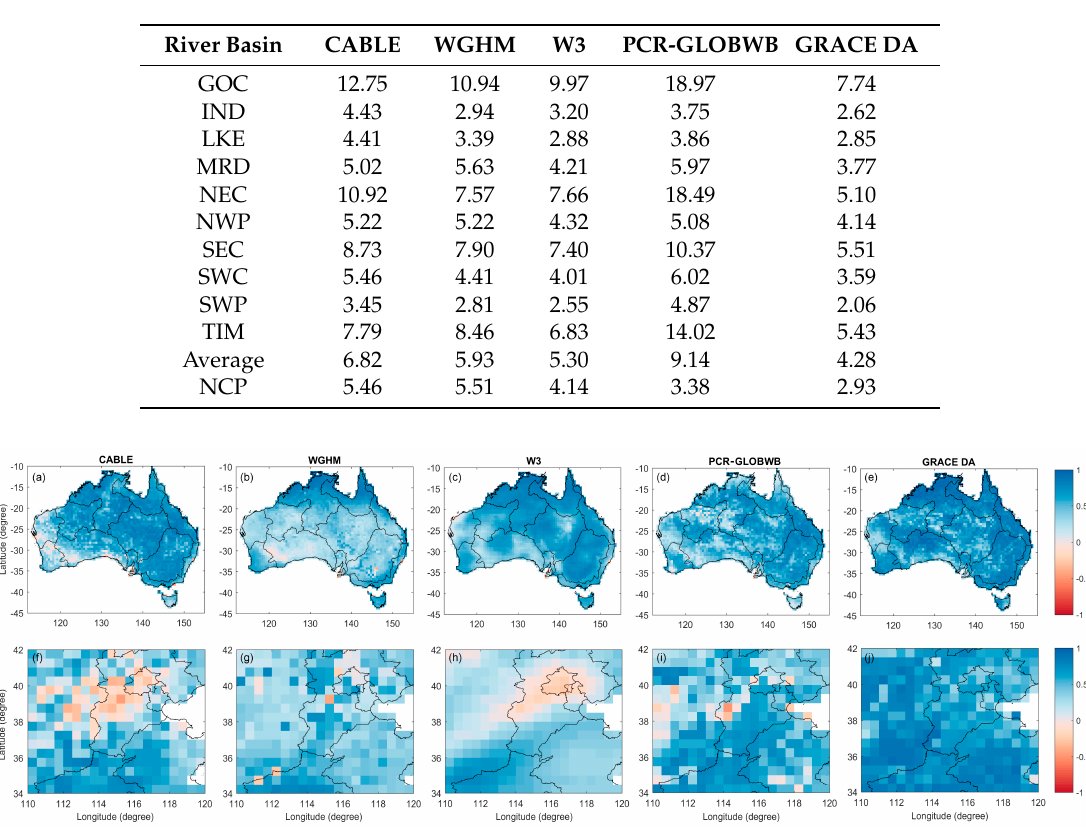
Table 2. The RMS difference (cm) between GRACE observation and the ∆ TWS estimates from four different models and GRACE DA in different study regions (see full name in Figure 1). The averaged value of Australia is also given.